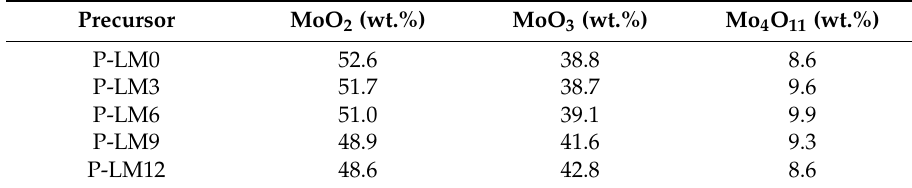
Table 2. Contents of MoO 2 , MoO 3 , and Mo 4 O 11 in each MoO 2 precursor calculated based on the XPS peak area for Mo 3d.